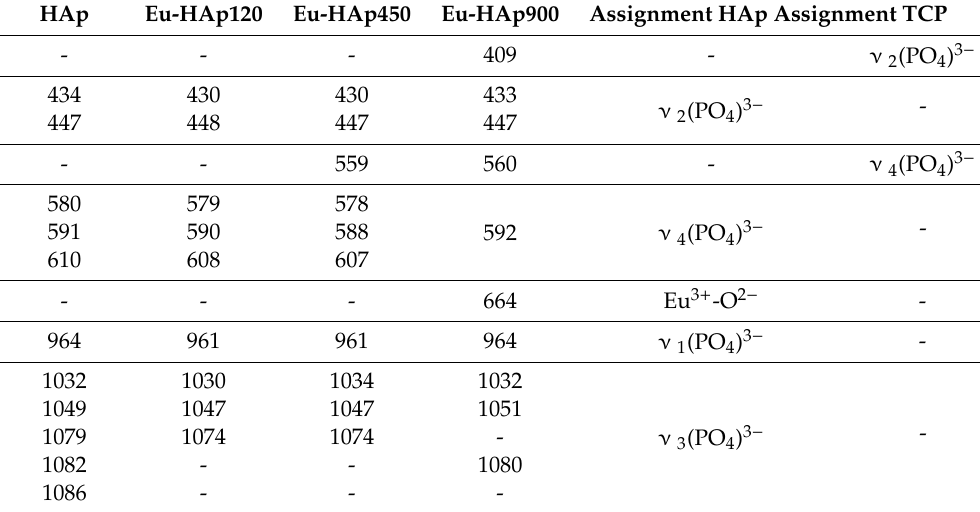
Table 7. Raman spectra and relative assignments for HAp samples.